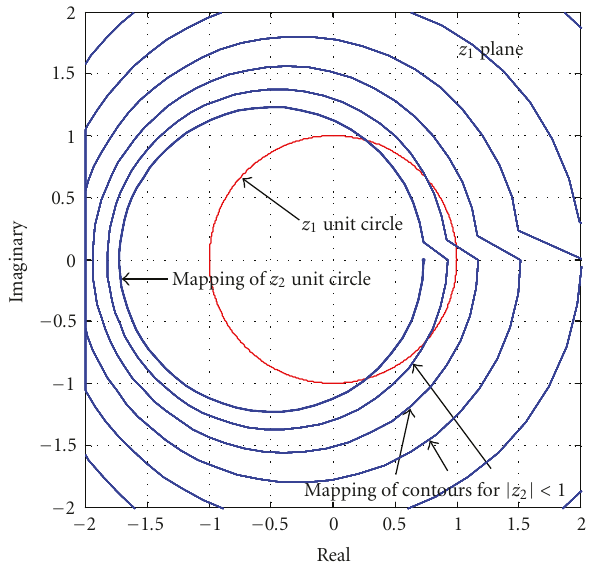
Figure 4: Mapping of z 2 unit circle onto z 1 plane for the stable filter.